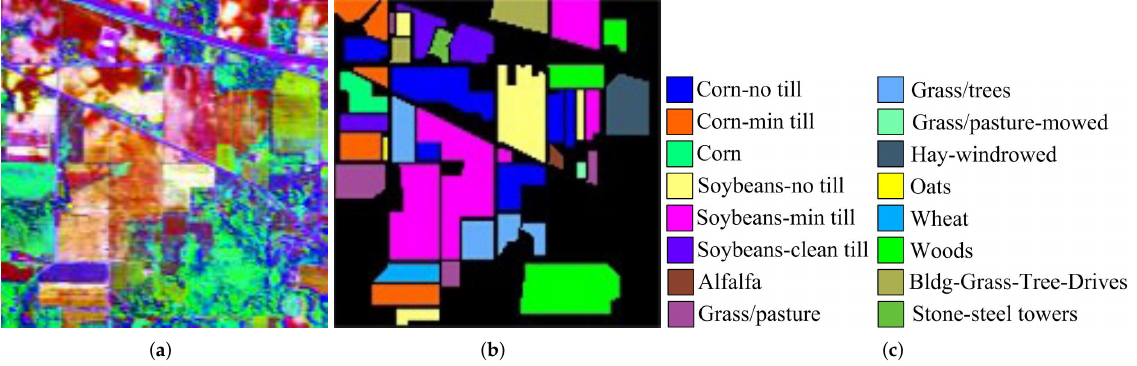
Figure 2. Indian Pines dataset. ( a ) False color composite. ( b ) Ground truth. ( c ) Label name.